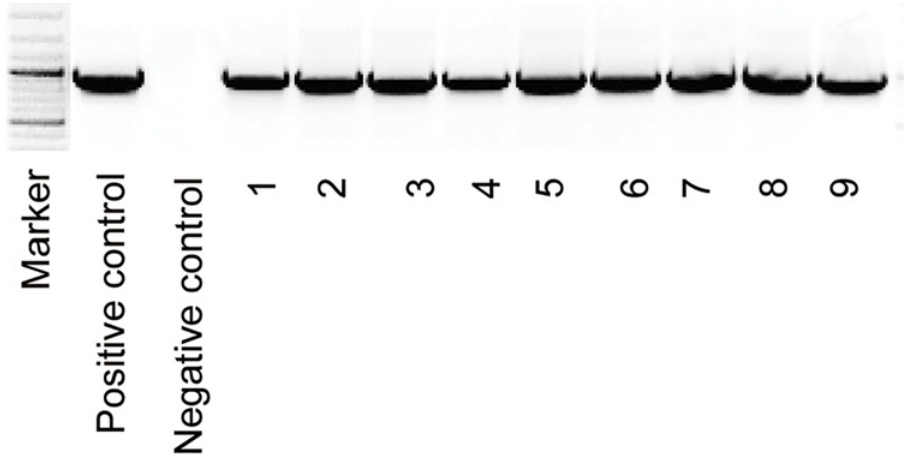
Fig 2. PCR identification of the OsARG gene in transgenic cotton. The under labels indicate the following samples: M, marker. 1, positive control. 2, negative control. 3 – 6, PCR analysis of four independent cotton plants containing ARG-26 genomic DNA. 7 – 10, PCR analysis of four independent cotton plants containing the ARG-38 genome DNA.